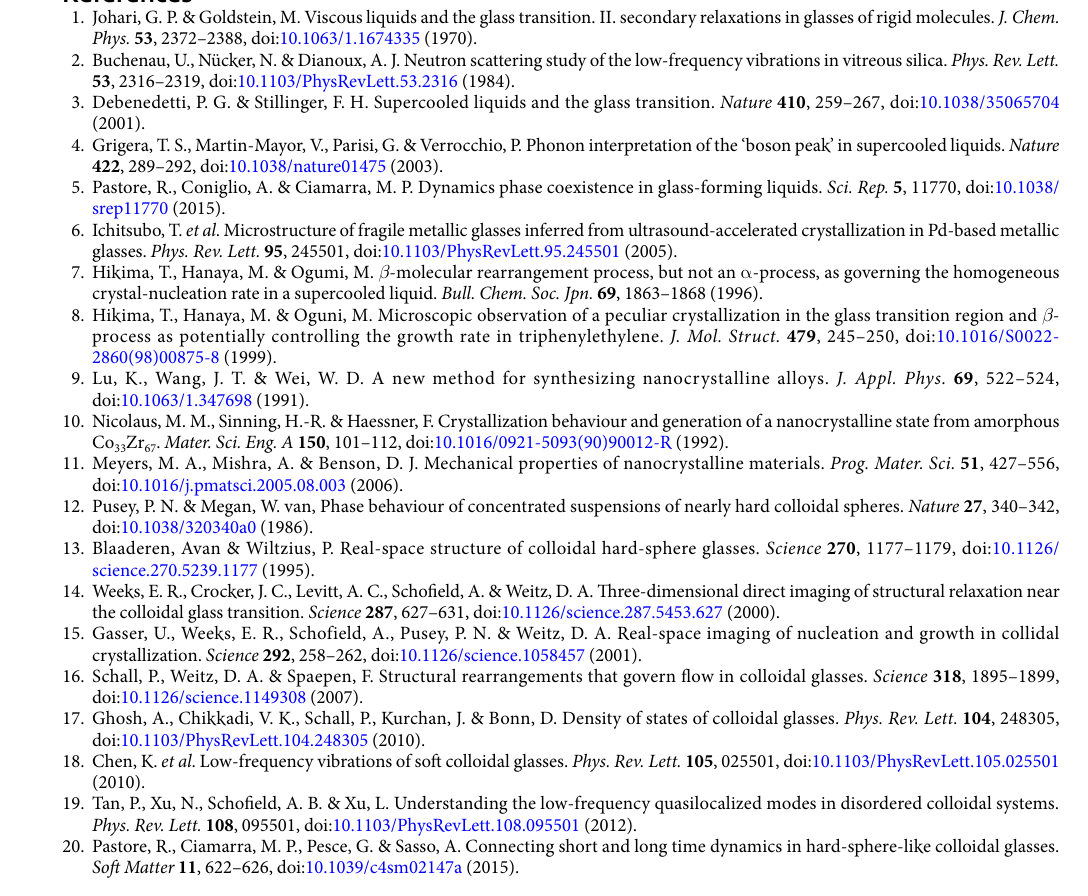
of particles around at 25- μ m height measured by counting the number of particles for a representative sample is 0.59. Near the top surface of the present samples, crystallization sometimes occurs without applying the mechanical oscillation. One may consider that we are observing the growth of the crystallized regions, not the crystallization inside a colloidal glass. However, as seen in a cross-sectional image taken after 60-s oscillation at 75 Hz (Fig. 1(e)), crystallized regions we observe are not connected with those near the top surface, indicating observed crystalli- zation is not the growth of crystallized regions near the top surface.